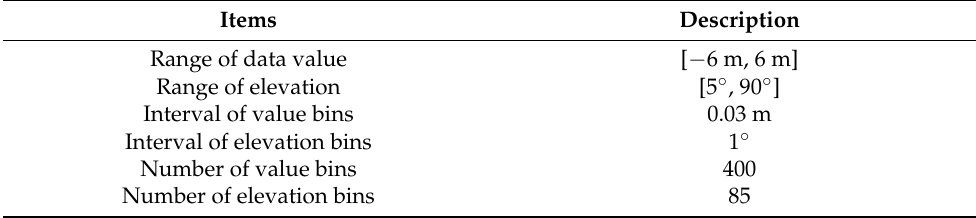
Table 1. Details of data